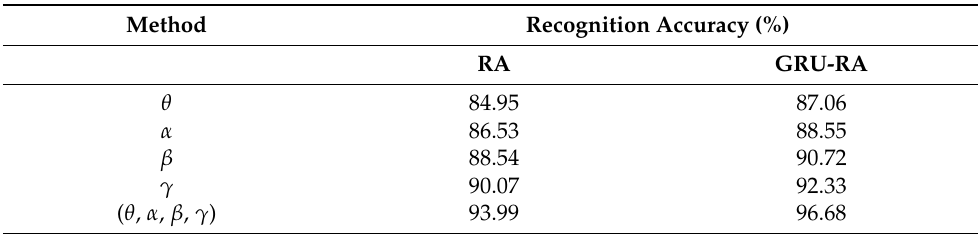
Table 5. Performance comparison between intra-frequency self-attention and inter-frequency band mapping based on the DEAP